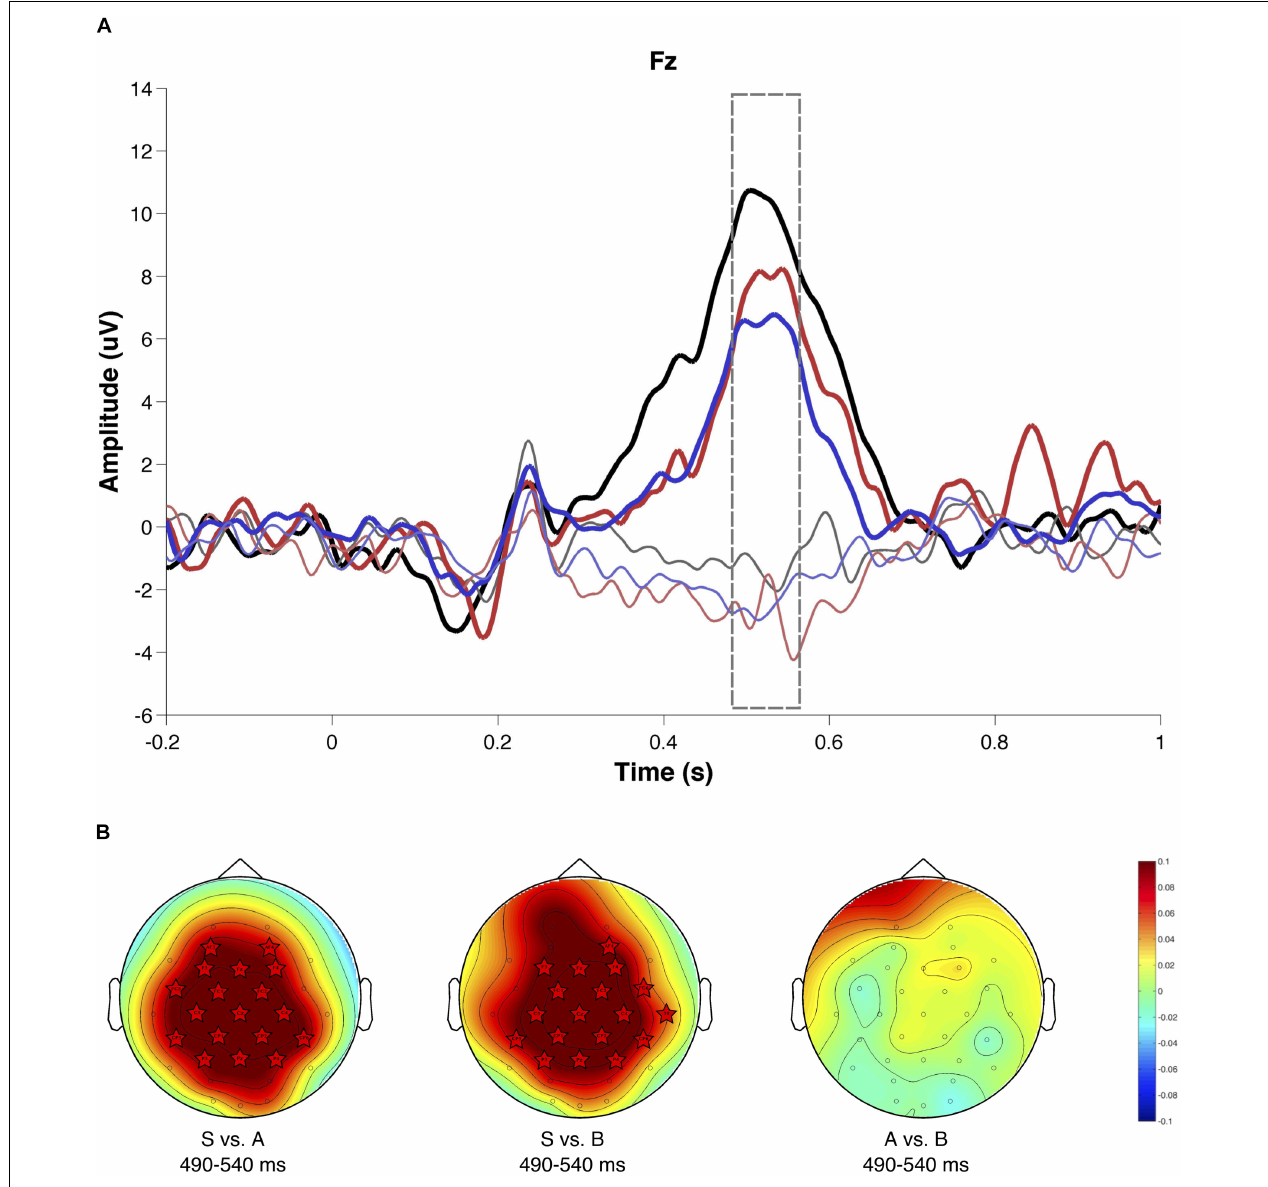
FIGURE 4 | Evoked brain activity associated with shift (Shift1) and repetition (Rep2, see text for details) trials. (A) The temporal window for ERP analysis of P300 area under the curve is shown dashed line. Silence condition is shown in black, A condition in red, and B in blue. The darker line shows the potential associated to shift feedback, while the soft line shows the potential to the second repetition of the correct rule. (B) Scalp amplitude difference maps for P300 (490–540 ms): stars show electrodes that present significant differences between conditions according to a non-parametric cluster-based permutation